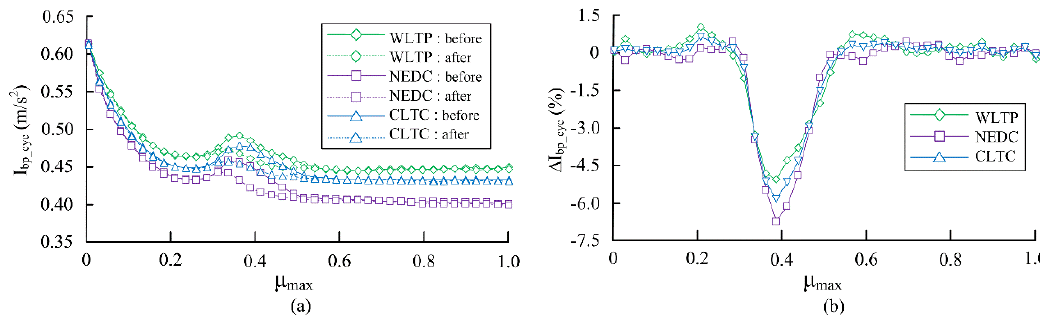
Figure 14. Optimization results in three driving cycles before and after optimization: ( a ) I bp_cyc and ( b ) ∆ I bp_cyc .